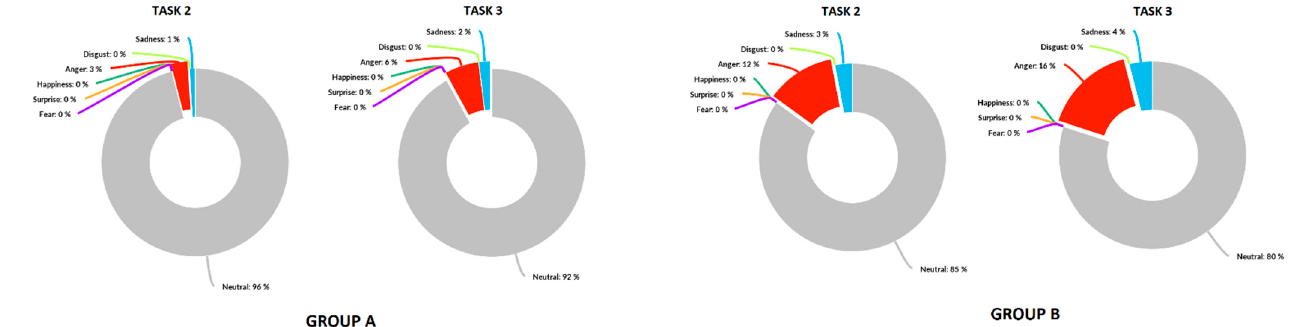
Figure 10. Comparison of the emotions expressed by group A who performed tasks 2 and 3 on a desktop computer, and group B who performed the same tasks on a smartphone.